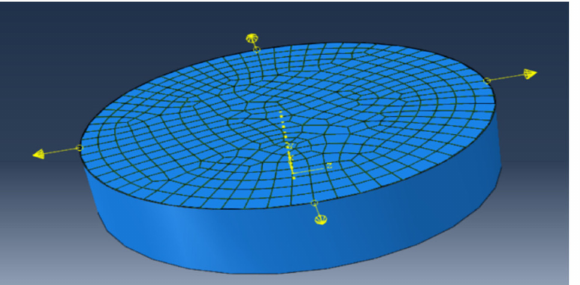
Figure 6. The residual force was applied in the nodes of elements of periphery of the interface before loading to simulate residual stress effect.